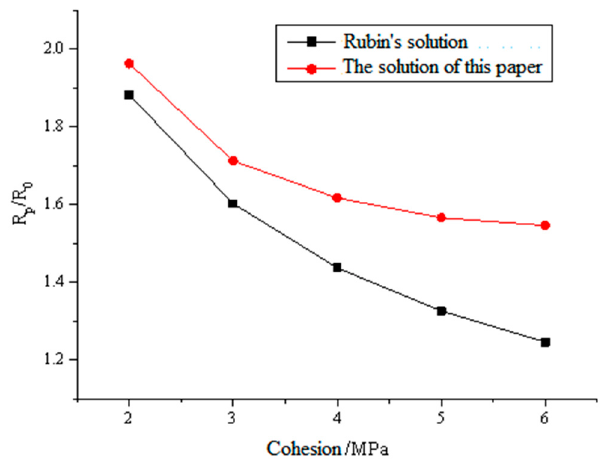
Figure 7. Plastic range under different